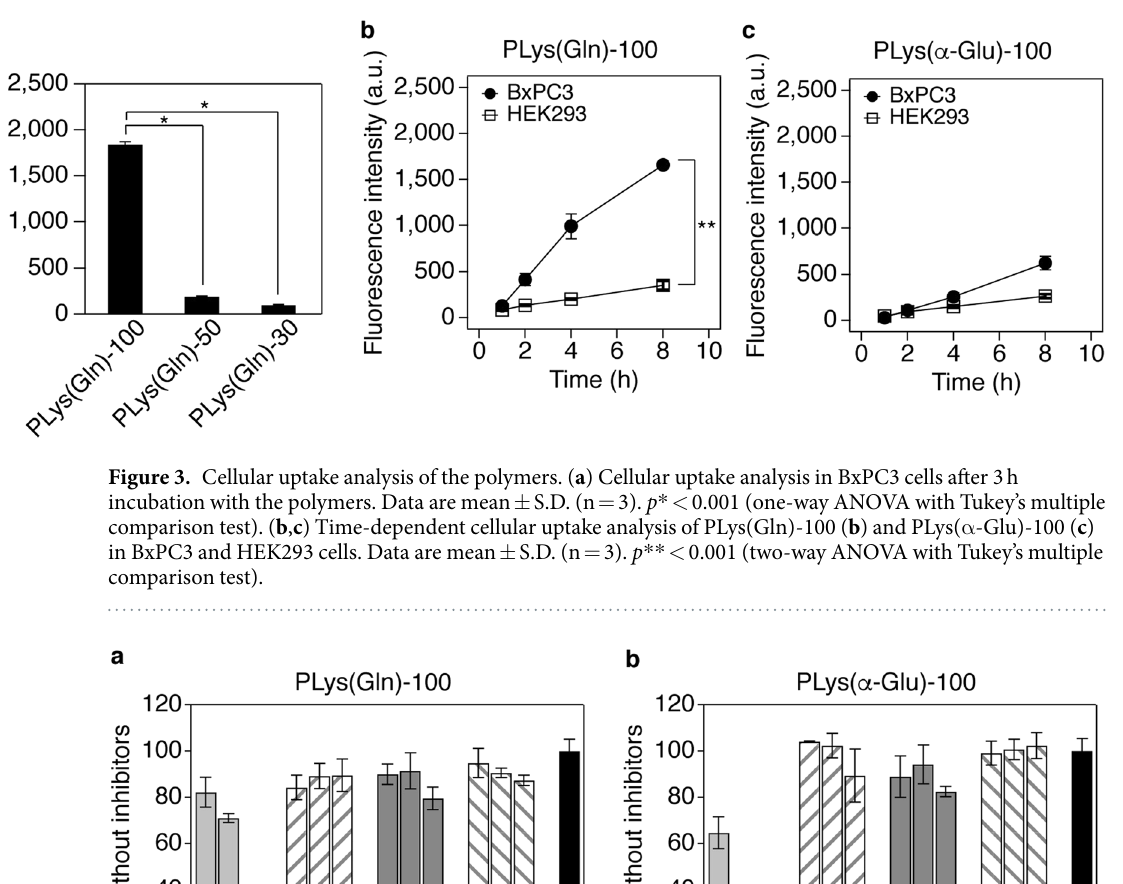
concentration-dependent inhibitory effect, while the other inhibitors showed negligible inhibitory effect, indi- cating the dominant contribution of ASCT2 to the uptake of PLys(Gln)-100. Similar inhibitory effects were also observed for PLys(Gln)-50 (Supplementary Fig. S17). Among above-mentioned glutamine transporters, ASCT2 has relatively high affinity with glutamine (Michaelis constant ( K m ) is 20–60 μ M 12, 23 , whereas the other transport- ers has K m in the range of approximately 150–1600 μ M 25–28 ). Because of this relatively strong interaction between ASCT2 and glutamine molecule, ASCT2 could be a dominant target transporter for PLys(Gln)-n. Moreover, the overexpression of ASCT2 on BxPC3 cells as shown in Fig. 2c may also contribute to the dominant role of ASCT2 for tumour cell-selective interaction of PLys(Gln)-n. Cellular uptake of PLys( α -Glu)-100 was also inhibited by only BzlSer while its inhibitory effect was higher compared to that of PLys(Gln)-100 (Fig. 4b), suggesting that PLys( α -Glu)-100 modestly interacted with ASCT2. Subcellular Distribution of the Polymers. Subcellular distribution of the polymer was then investigated using confocal laser scanning microscopy (CLSM) to assess the internalization of the polymers. As shown in Fig. 5a, in the BxPC3 cells incubated with PLys(Gln)-100 at 37 °C, the polymer (red) was located at intracellular space, and colocalized (yellow) with the late endosome/lysosome indicator, Lysotracker Red (green). In contrast, when BxPC3 cells were incubated with the polymer at 4 °C to suppress the endocytosis, the polymer was located only on the cellular membrane, and did not colocalize with the late endosome/lysosomes. In addition, mean